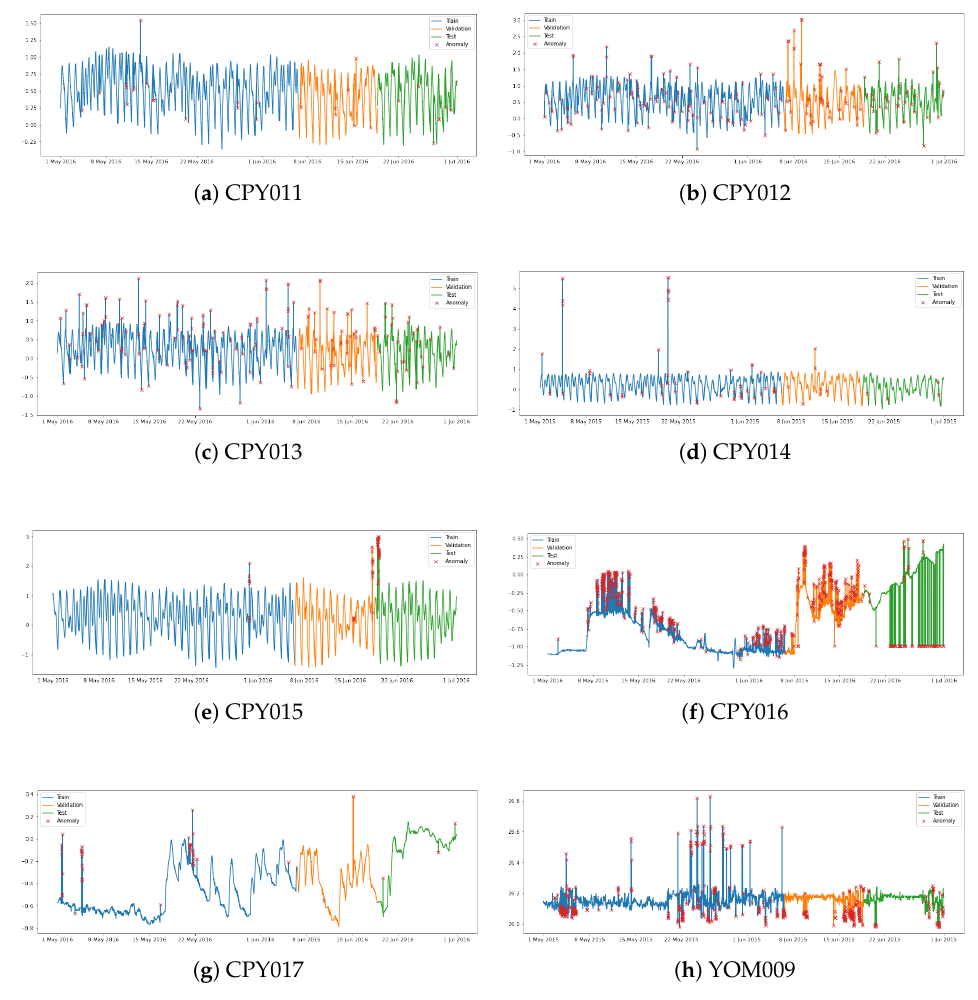
Figure 2. Water level data from eight stations: CPY011, CPY012, CPY013, CPY014, CPY015, CPY016, CPY017, and YOM009 ( a – h ). The different colours show the partitions of the data for training (blue), validation (orange) and testing (green). The anomalies are indicated by red crosses,